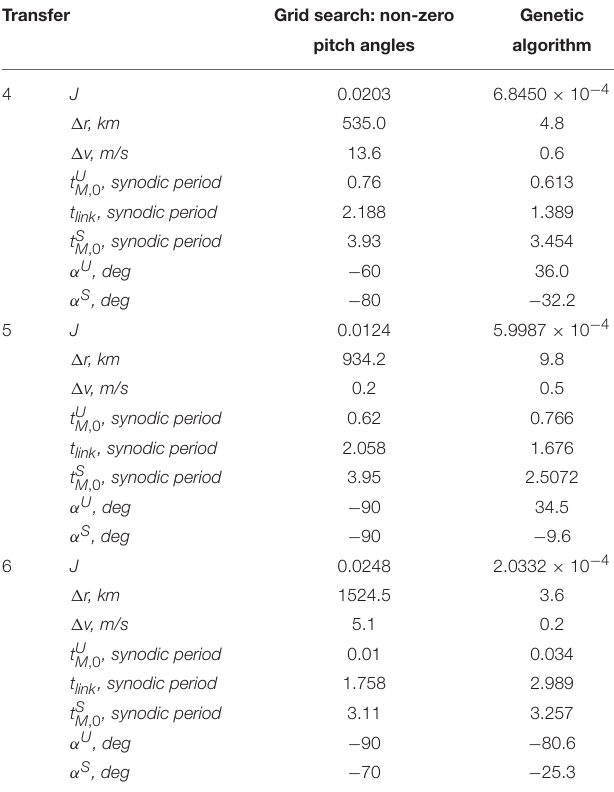
TABLE 3 | Objective value, dimensional errors on position and velocity, and further details for transfers 4–6 for different approaches in the search for heteroclinic